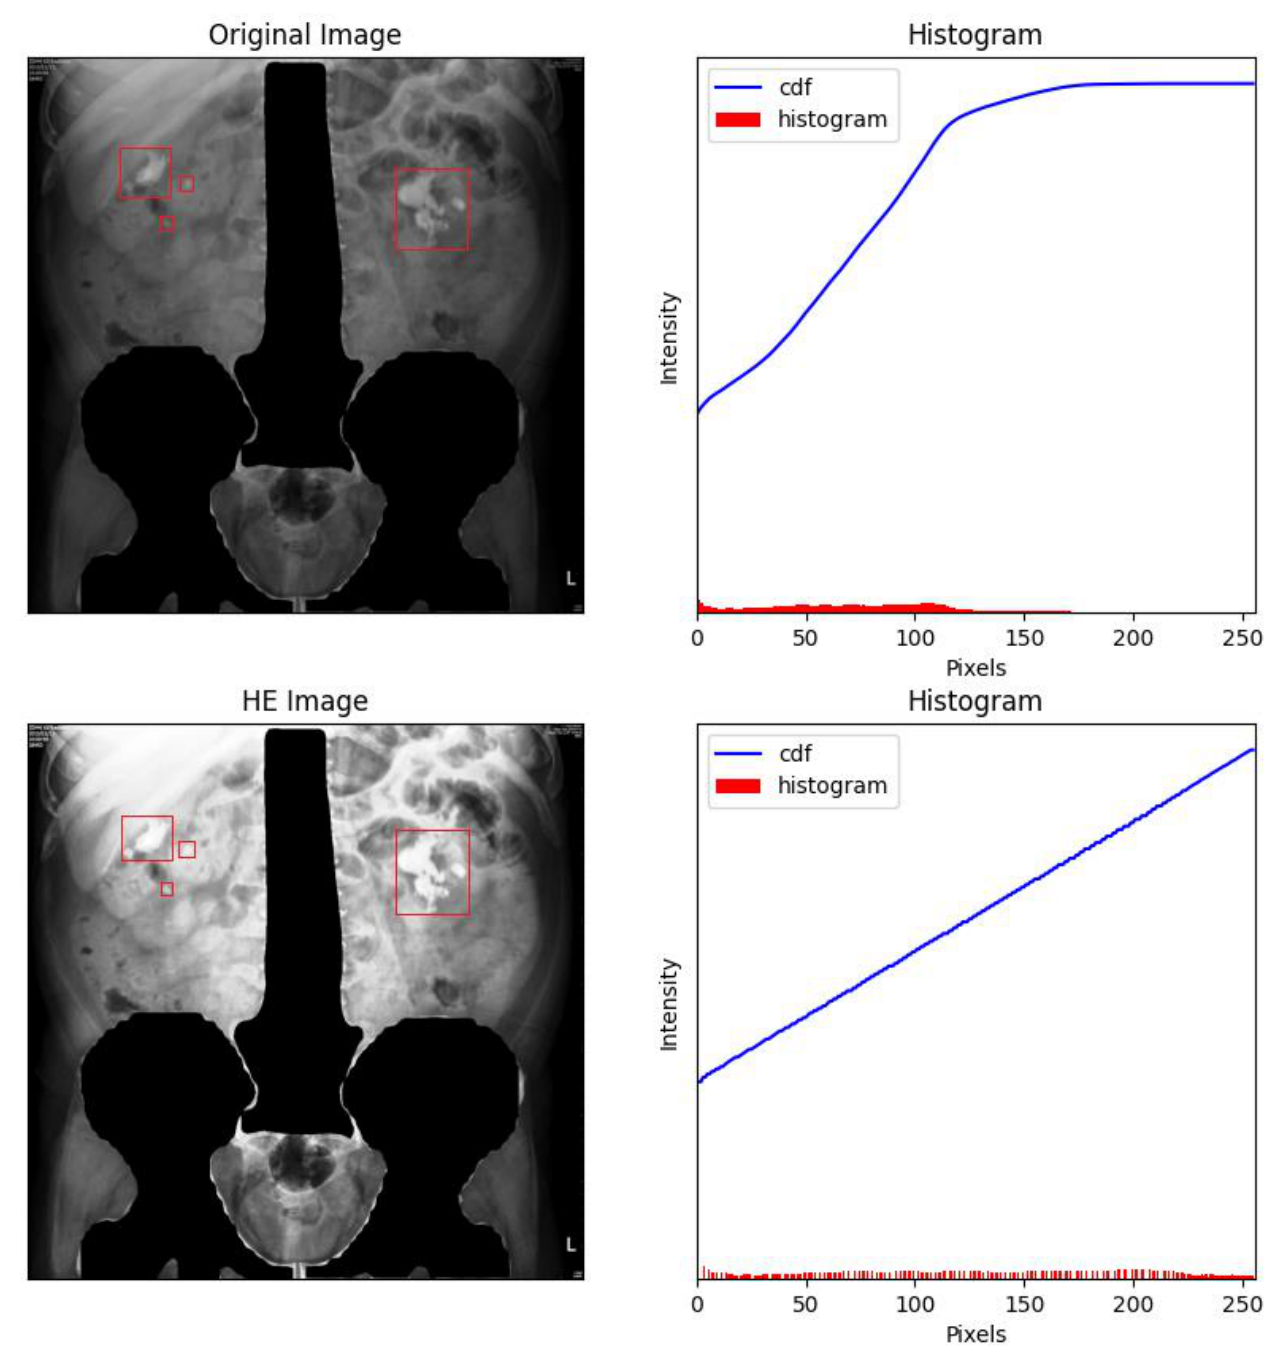
Figure 6. Masking the spine and pelvis greatly decreased the high-intensity areas of each image. The renal stones were labelled with red frames by the experts.